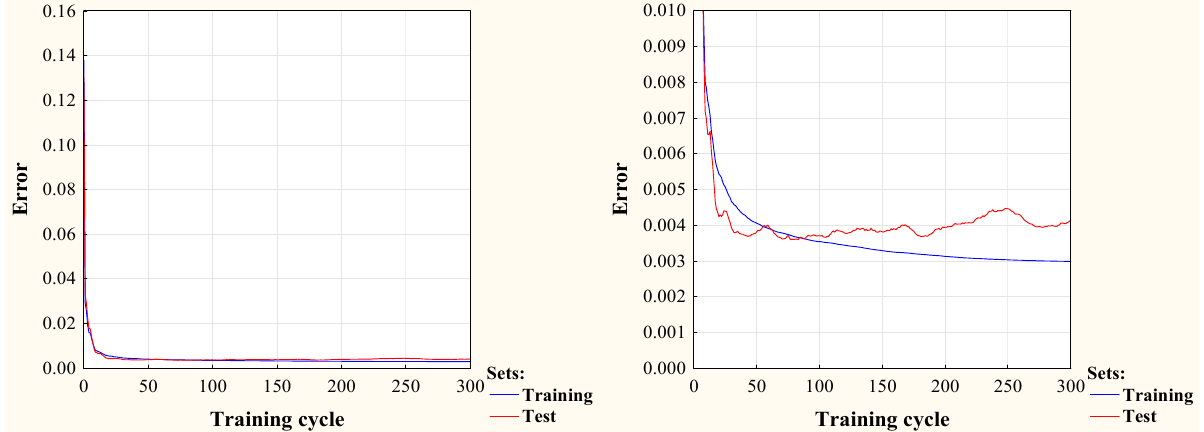
Figure 7. Learning plot of the MLP 20-10-3 networks.